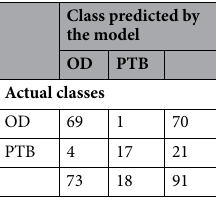
Table 5. Confusion matrix report for improved weighted voting ensemble method.